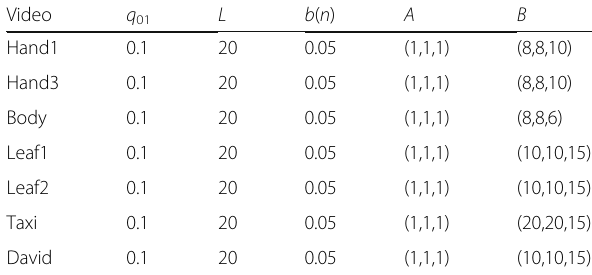
Table 2 Parameter values used in the experiments